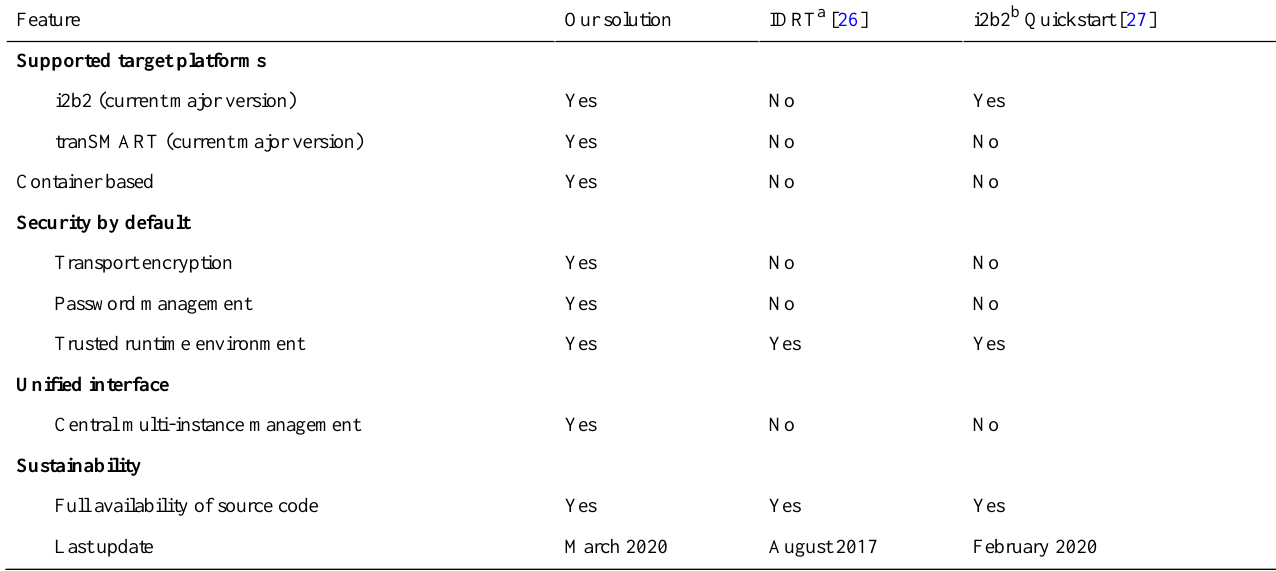
Table 4. Comparison of provisioning infrastructures: Our solution, IDRT a and i2b2 b